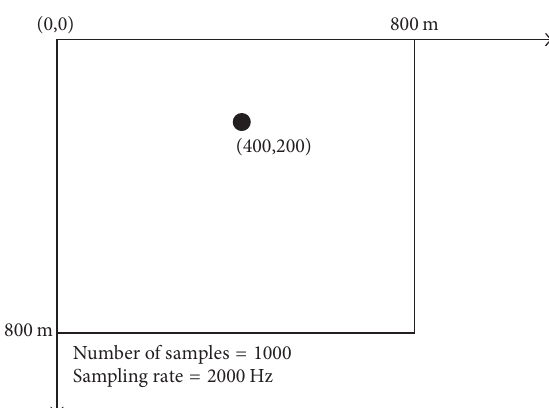
Figure 6: The single-point model with homogeneous velocity structure.